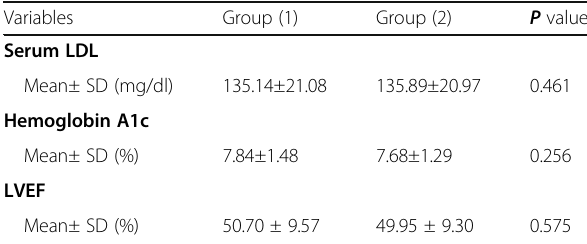
Table 3 Baseline laboratory parameters